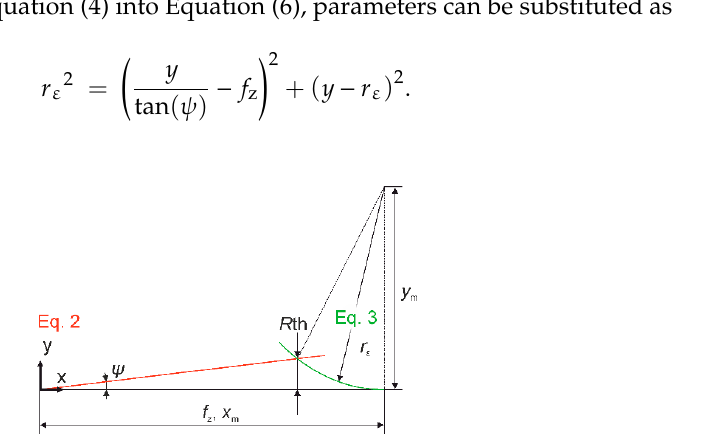
Figure 2. Schematic view on ( a ) a two dimensional engagement situation during milling, ( b ) two consecutive tooth feeds, ( c ) single milling marks with influencing parameters.